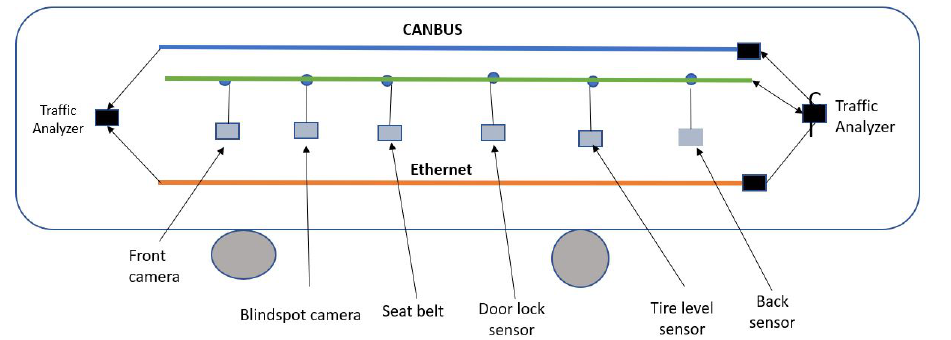
Figure 2. Dual data path vehicular